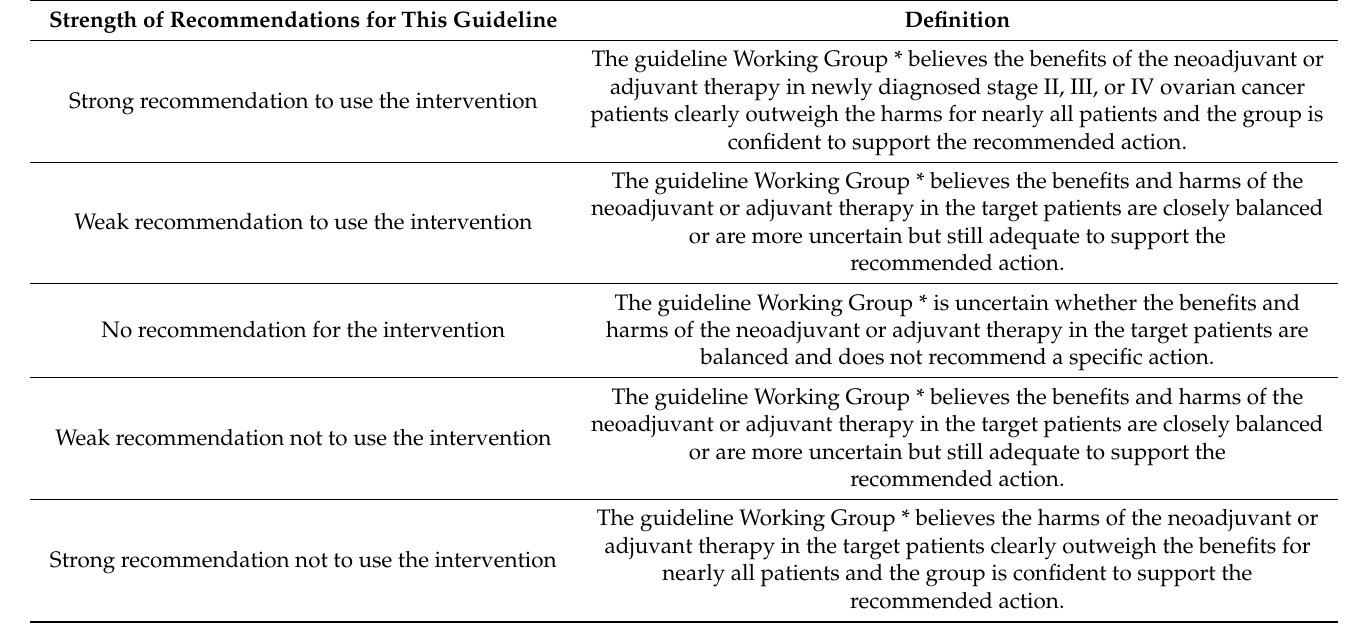
Table 1. Strength of recommendations for this guideline. The factors considered in the below judgments include desirable and undesirable effects of the neoadjuvant and adjuvant therapy, the certainty of evidence, patient preference, health equity, acceptability, feasibility, and